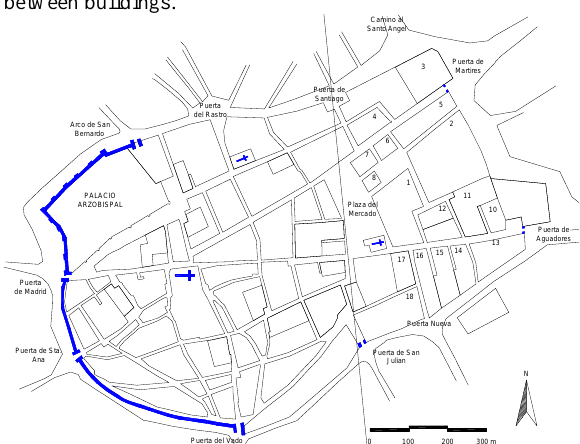
Figure 4. Hypothetical plant of Alcalá in XVIII